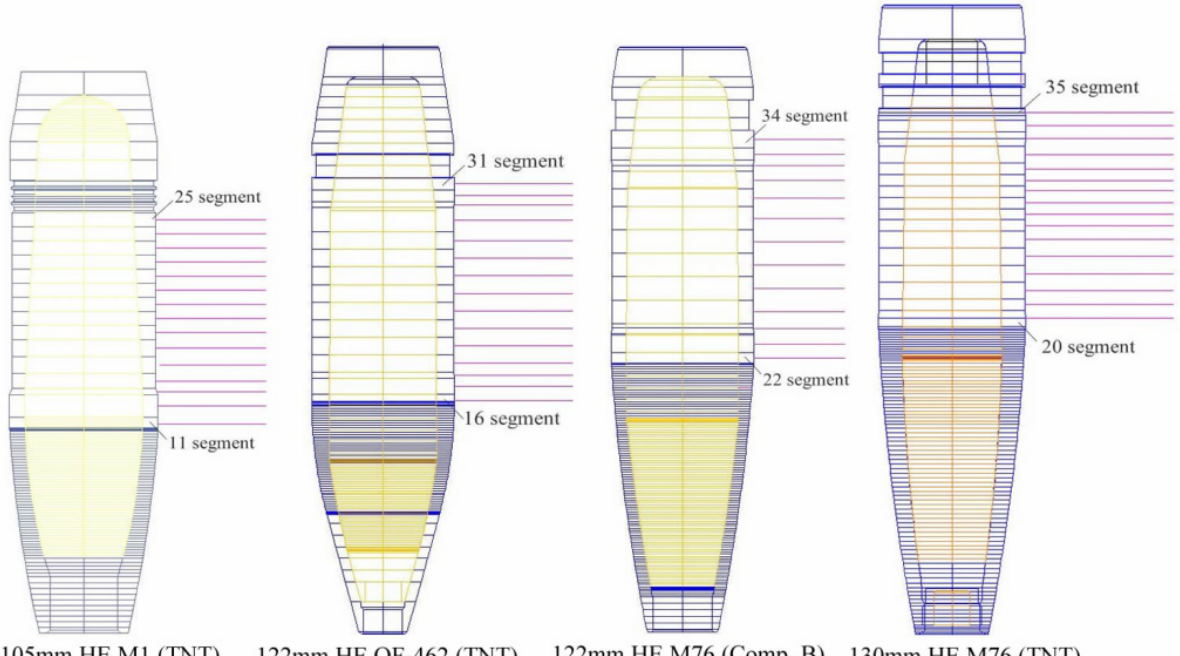
Figure 10. Body segments of artillery projectiles, for which Gurney method is applied, used in our model for determination of the lethal radius